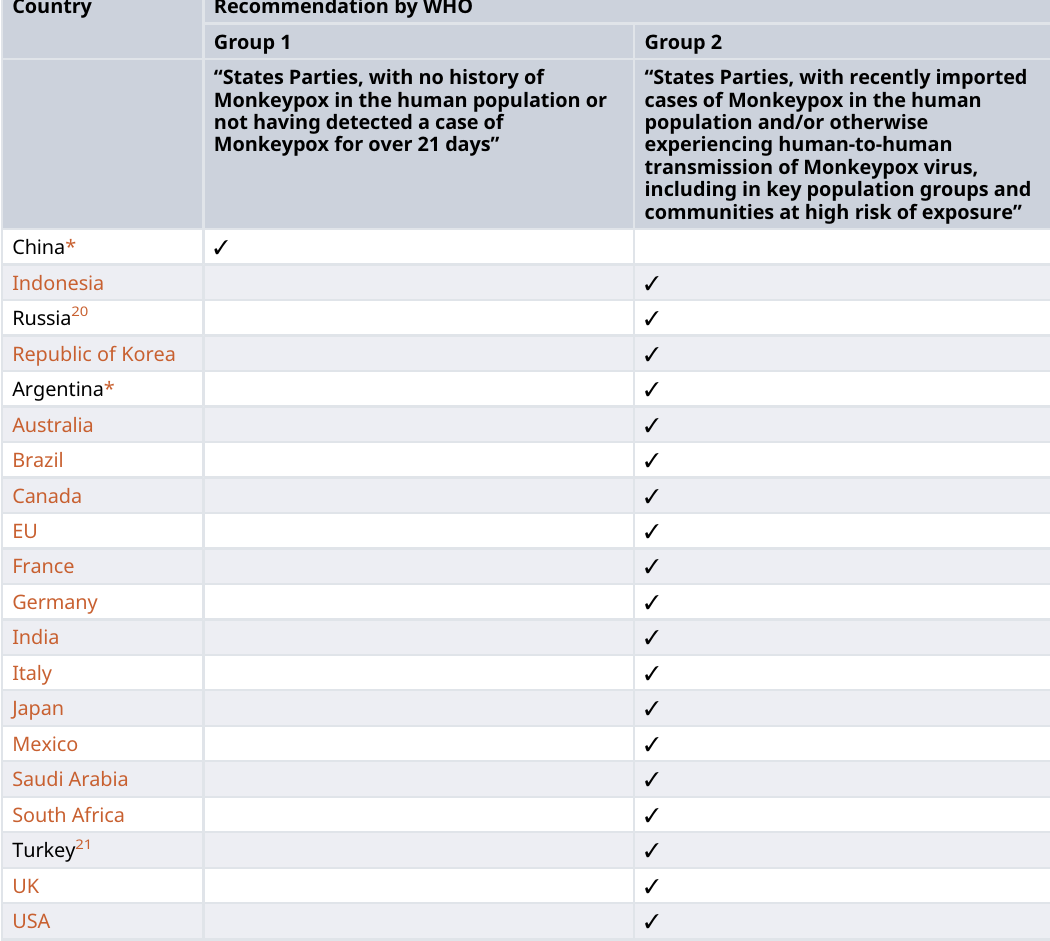
Table 1. Categorization of G20 states parties according to the temporary recommendation issued by WHO Director General. 13 Country Recommendation by WHO Group